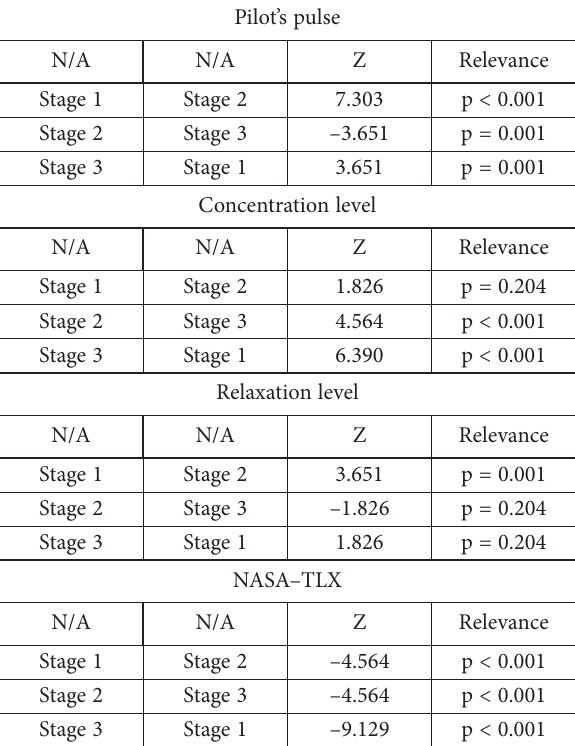
Table 3. Dunn’s test results for four quantitative